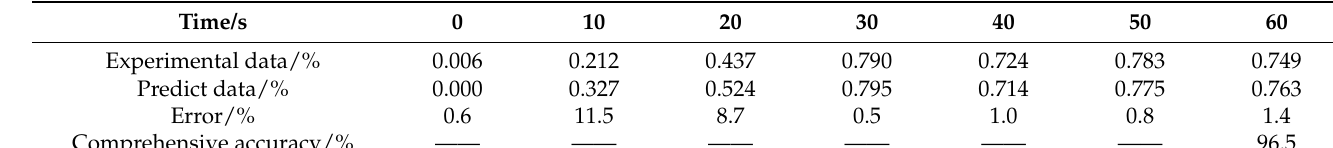
Figure 6. ( a ) Training process curve of a BP neural network; ( b ) neural network predictions.